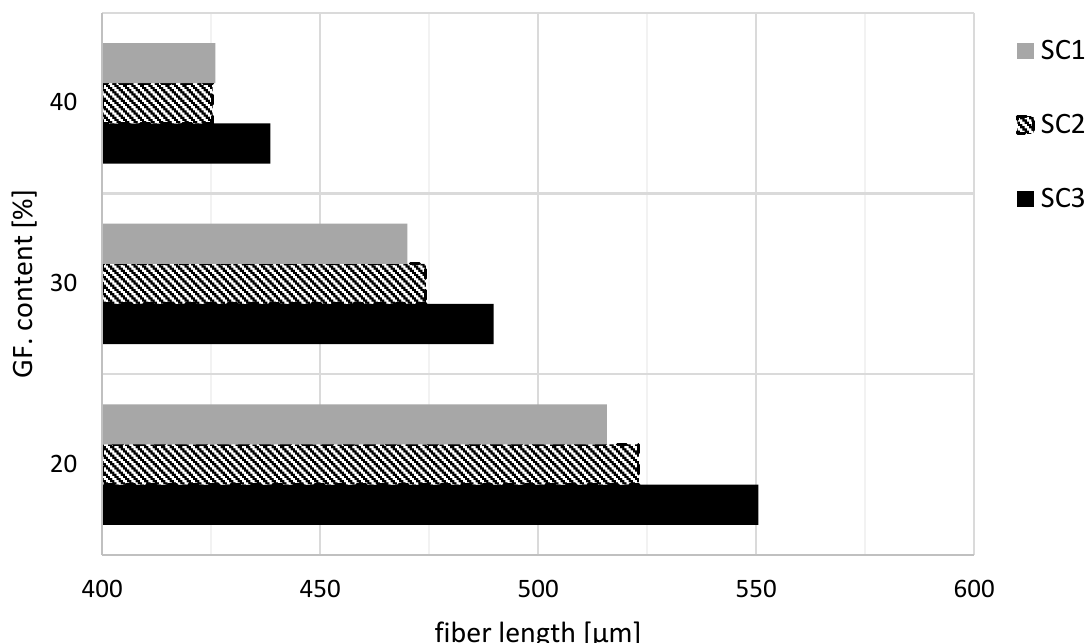
Figure 5. Results of the simulation of the fiber lengths for the glass fiber contents of 20, 30, and 40 wt.% for the three different screw configurations.